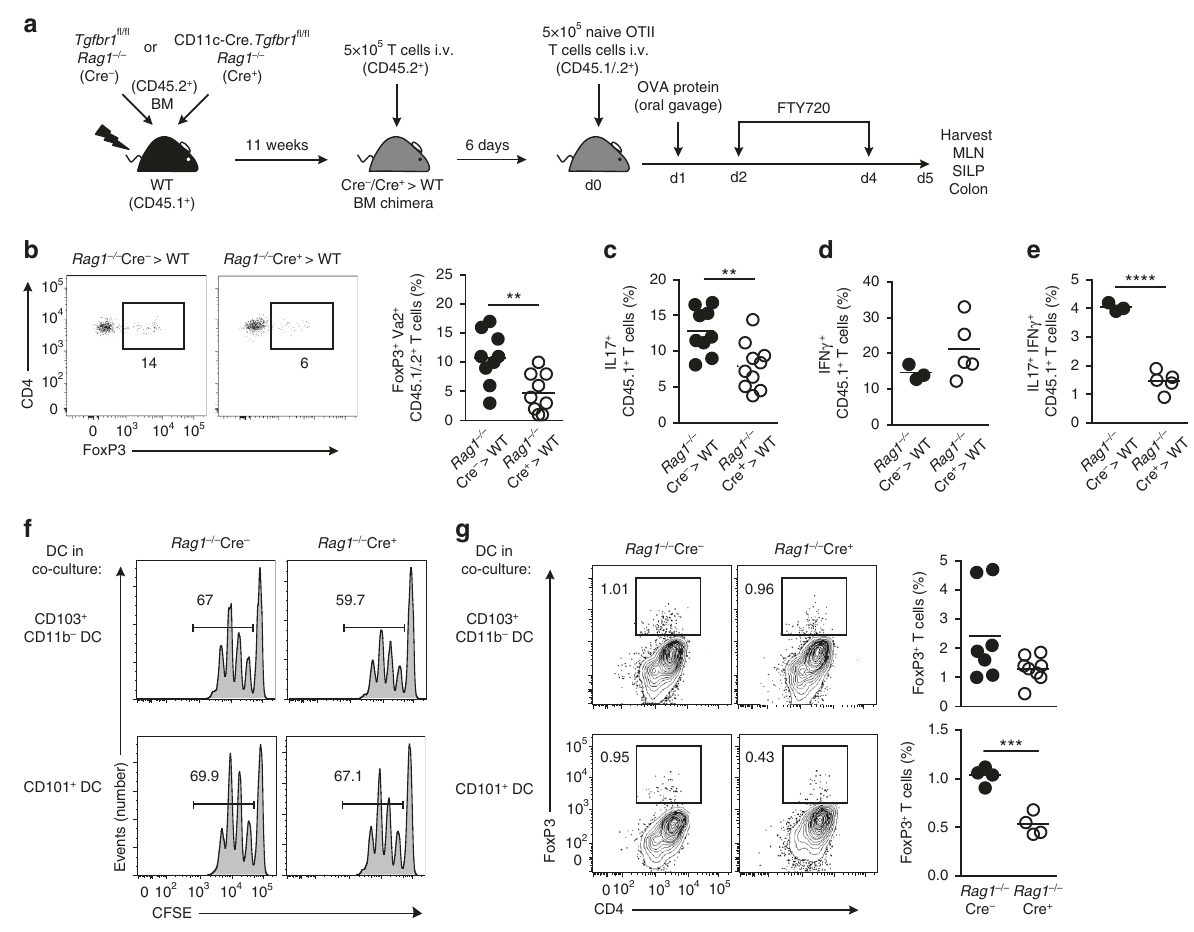
Fig. 7 TGF β R1 signalling is required for induction of regulatory T cells by DC in vivo and in vitro. a Experimental scheme for induction of Tregs in vivo. b Representative expression of FoxP3 + by adoptively transferred OTII T cells (V α 2 + CD45.1 + CD45.2 + ) from MLN of Rag1 − / − Cre − → WT or Rag1 − / − Cre + → WT BM chimeric mice 4 days after oral administration of 50 mg OVA ( left panels ). Scatterplot shows the frequency of FoxP3 + T cells among all V α 2 + CD45.1 + CD45.2 + T cells ( right panel ). Each symbol represents an individual animal and the horizontal bar represents the mean. Data are pooled